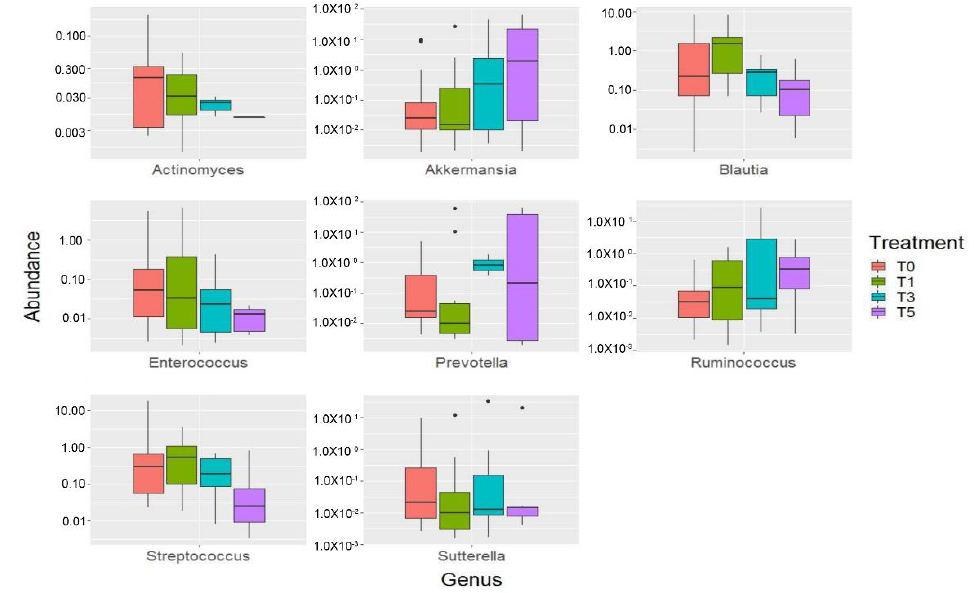
Figure 7. OTU distribution of the gut microbiota during the time-course of the CMA group computed by DeSeq2 test at the genus level. The interquartile range is represented by the box and the line in the box is the median. The whiskers indicate the largest and the lowest data points, respectively, while the dots symbolize outliers. Only statistically significant OTUs ( p < 0.05) are plotted.